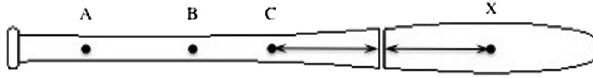
3. Figure used in the c.m. location task. Students were told that a bat has been cut into two pieces. They were asked (1) if the center of mass of the left piece is closest to point A , B , or C , and (2) if the center of mass of the right piece is to the left of, to the right of, or at point X . They were told that points C and X are the same distance from the break. In both cases, students were given the option “ there is not enough information.